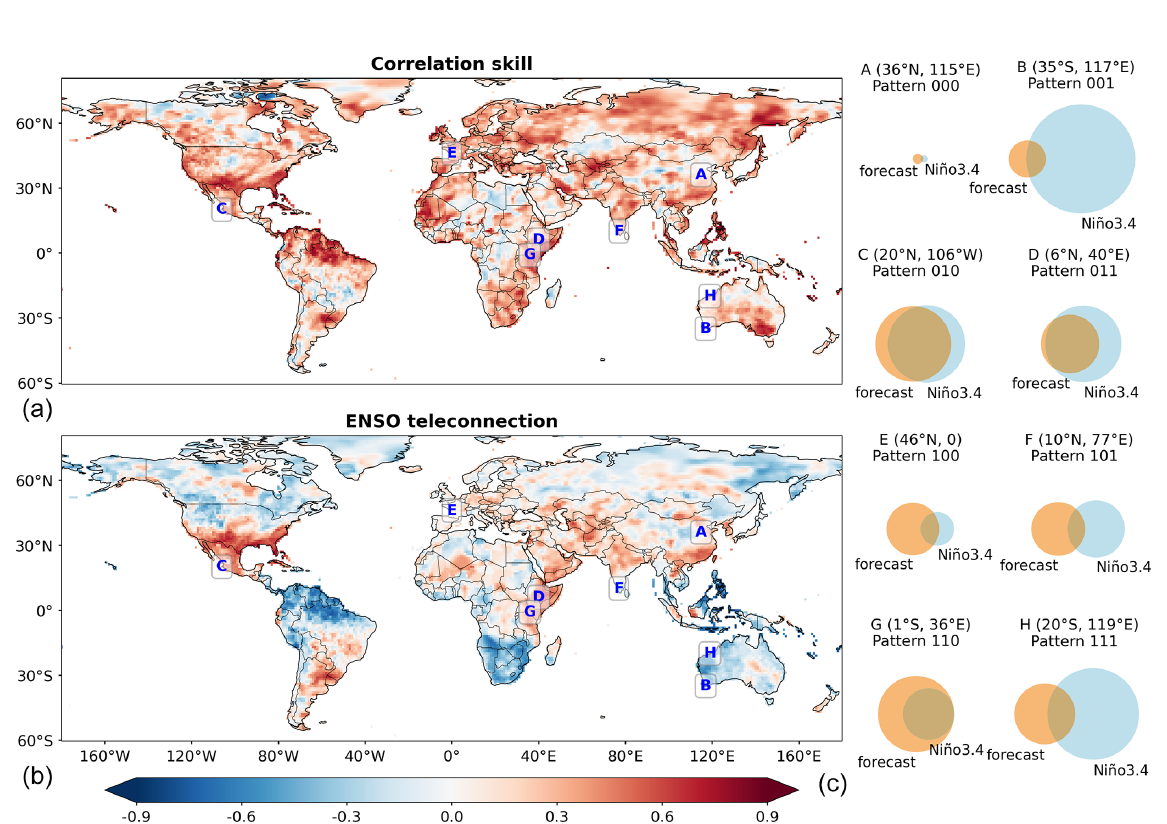
Figure 2. Spatial plots of correlation skill (a) and ENSO teleconnection (b) for global precipitation in DJF, and Venn diagrams (c) of overlapping and differing information for eight selected grid cells under the eight